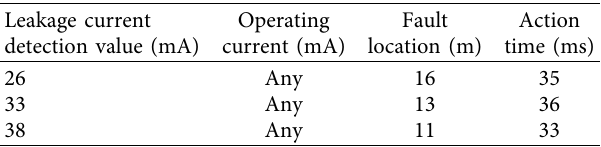
a variety of trigger conditions can be set, as shown in Figure 3. The leakage current of the selected test analog trigger signal shall not be less than 2 times the maximum